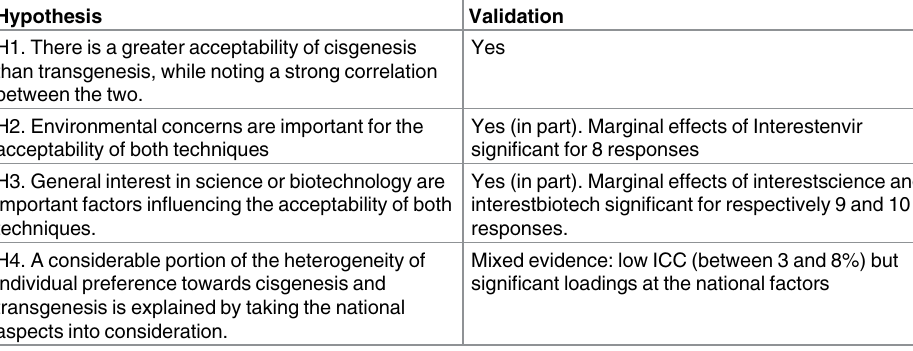
Table 8. Validation of the